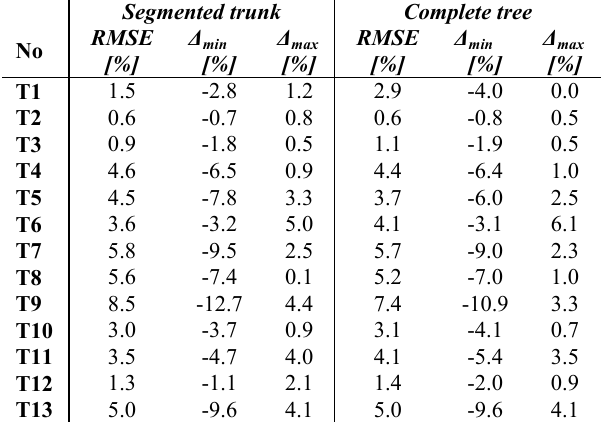
Table 4. RMSE and the minimum and maximum deviations of the average rotated volume differences to the initial volume ( α = 0°) per trunk and tree